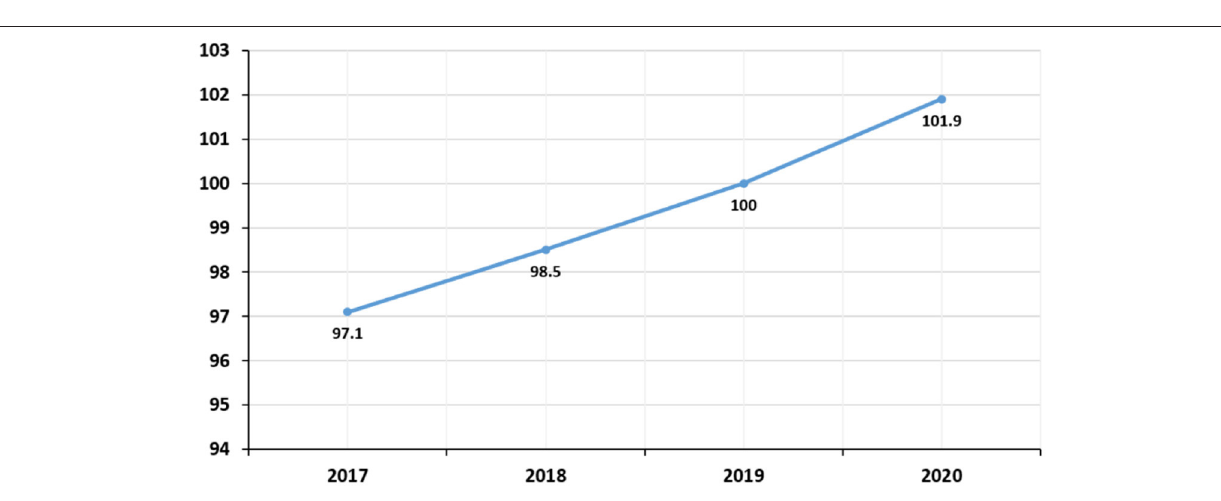
FIGURE 2 | Consumer Price Index (CPI) for food in Singapore, 2017–2020. Source: Singapore Department of Statistics, Ministry of Trade and Industry (MTI), Statistical Appendix, Consumer Price Index. https://www.mti.gov.sg/-/media/MTI/Resources/Economic-Survey-of-Singapore/2021/Economic-Survey-of-Singapore-